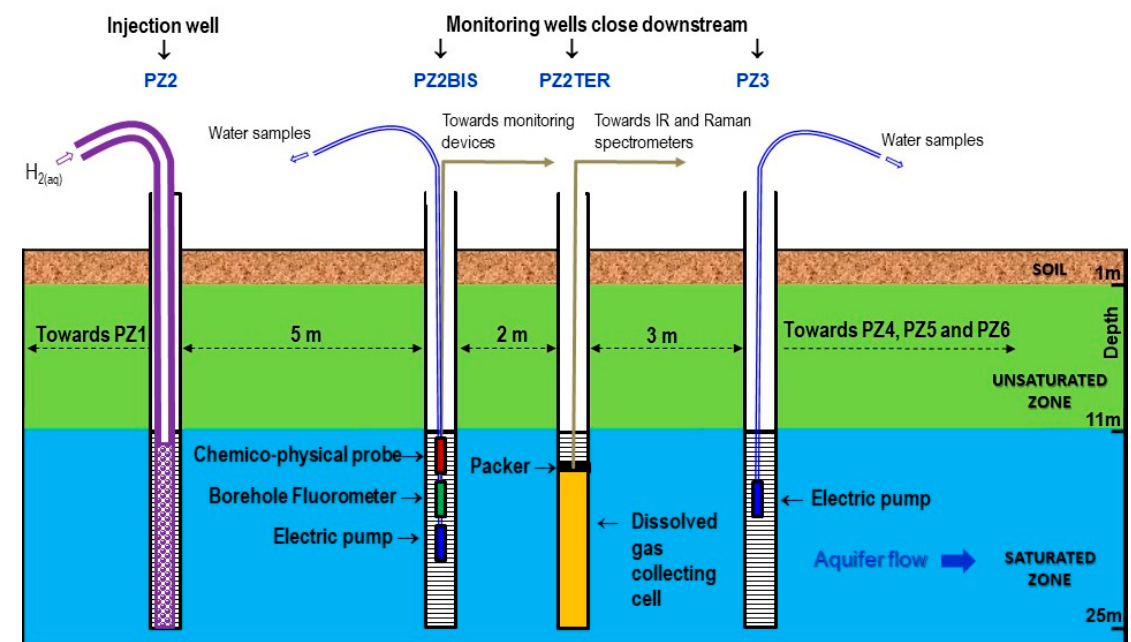
Figure 3. Various devices installed at the injection well and the near downstream monitoring wells.